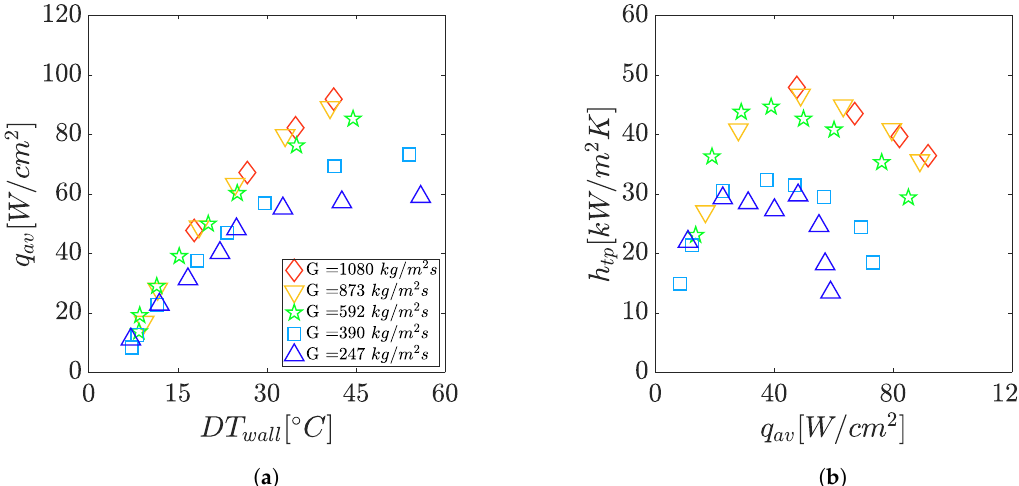
Figure 10. Boiling curves ( a ) and channel average heat transfer coefficient ( b ) in Geometry B for a nominal saturation ◦ temperature of 30 C at the outlet of the